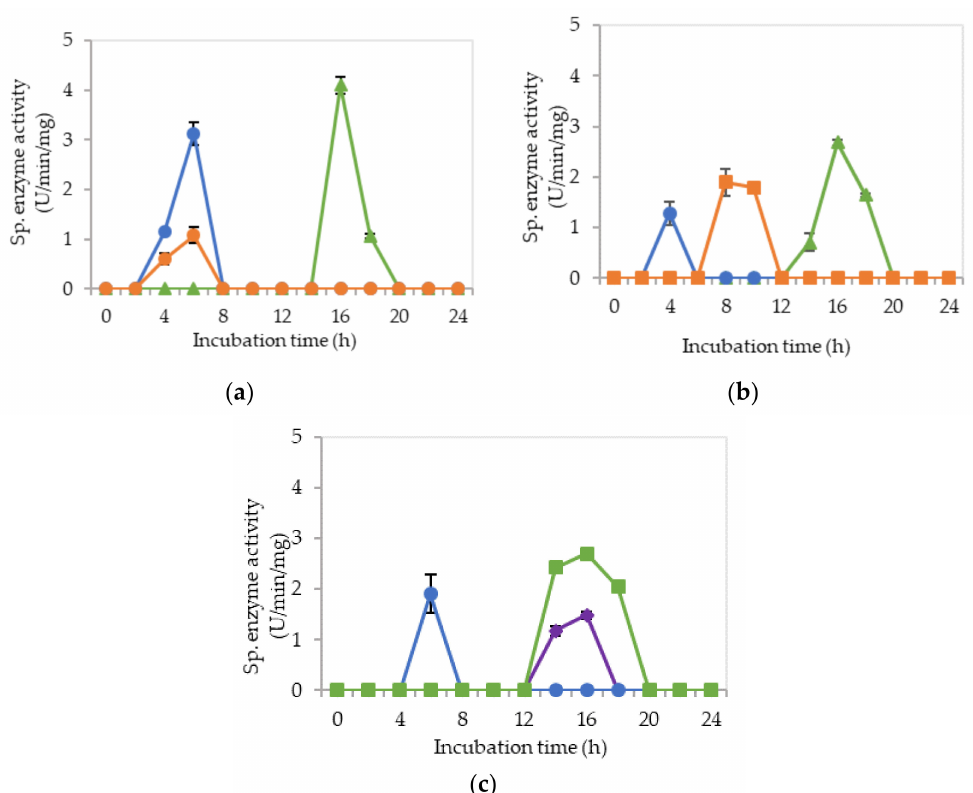
Figure 4. Specific extracellular cellulolytic and hemicellulolytic activities; ( • ) endoglucanase; ( (cid:4) ) exoglucanase; ( (cid:78) ) β -glucosidase and ( (cid:7) ) mannanase of Lactobacillus plantarum RI 11 grown in M2 (rice straw and soybean pulp) for 24 h. The enzyme activities were detected at three di ff erent pH levels: ( a ) pH 5; ( b ) pH 6.5; ( c ) pH 8. The error bars represent the standard deviation of